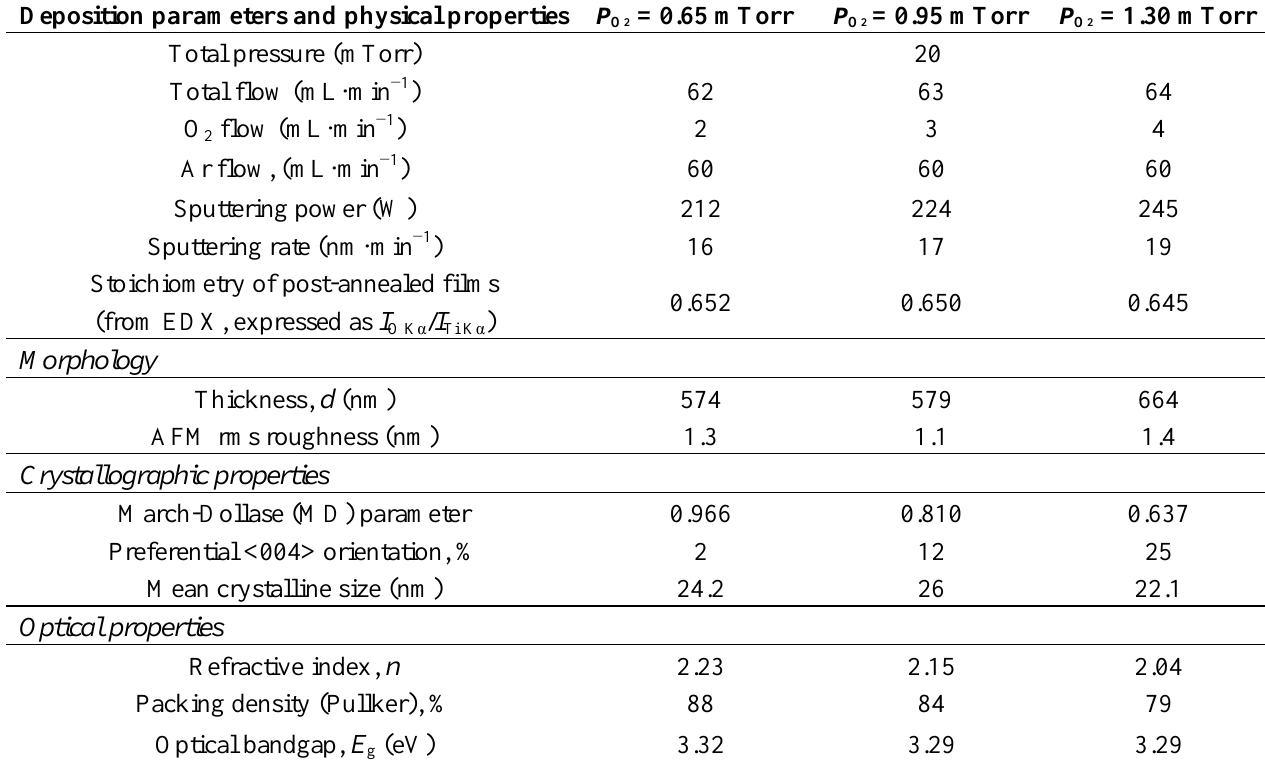
pressure, P 2 O 2